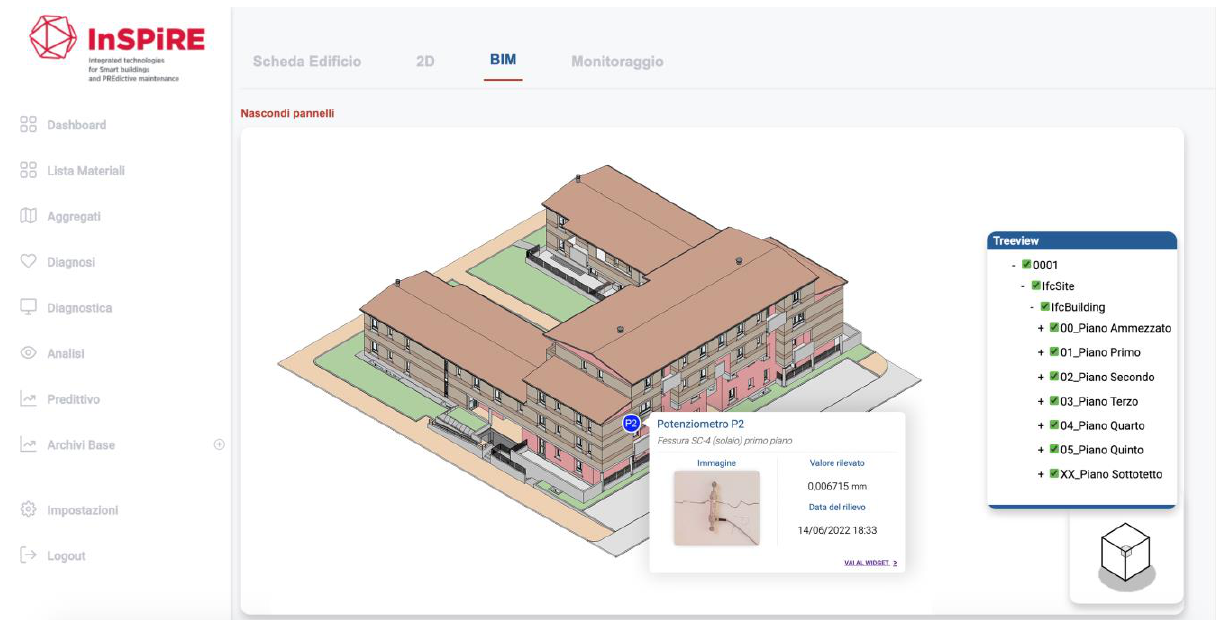
Figure 3. Data visualization in the BIM